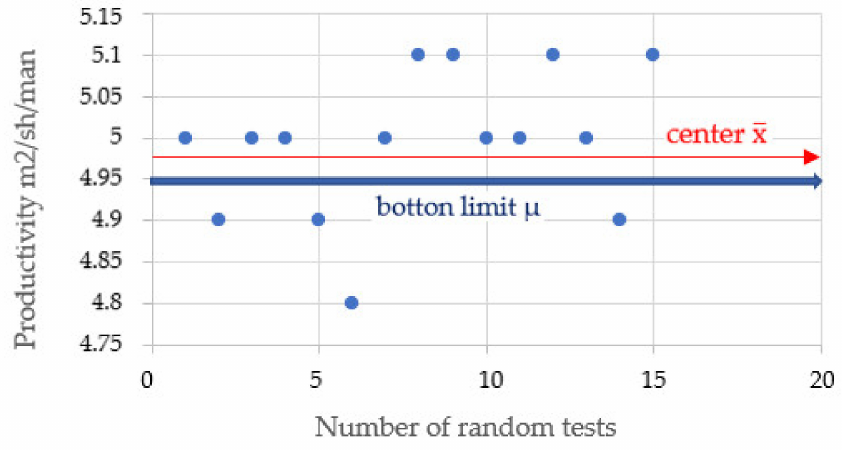
Figure 11. The graphic illustration of tiling works performances including the mean